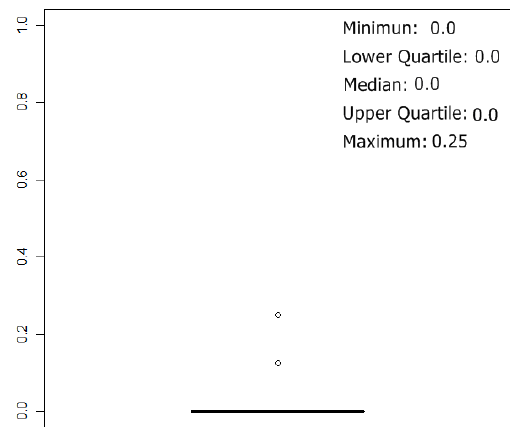
Figure 9. Boxplot of the error calculated over the test sets, considering the 50 simulations generated applying 10 rounds of 5-fold cross-validation over the 40 prototypes. Class Prototypes of acetic-1 g/L class were not